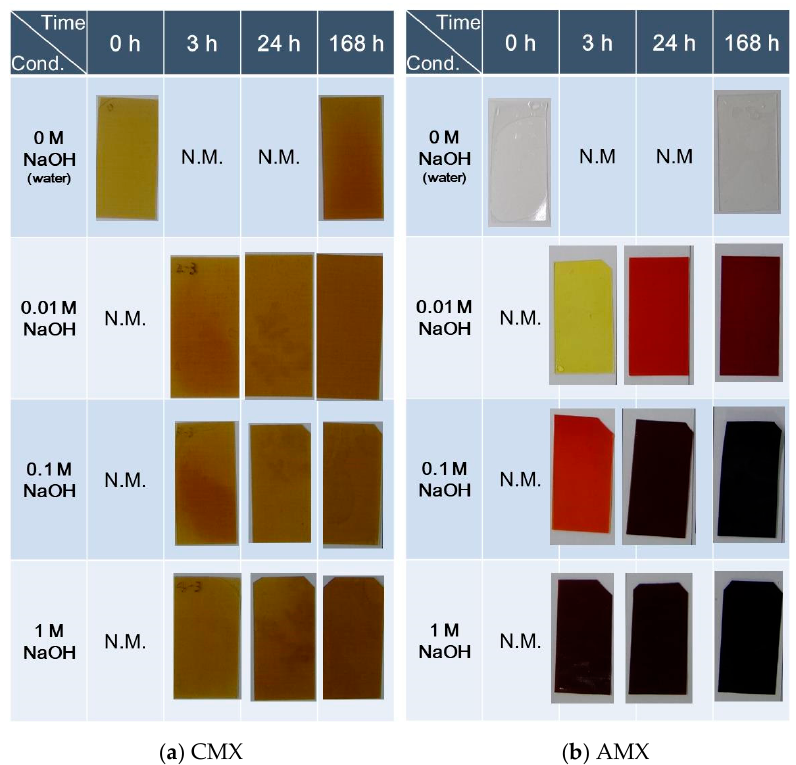
Figure 5. Color change of test pieces with respect to various NaOH concentrations and immersion time periods (40 °C); ( a ) CMX; ( b ) AMX (N.M - Not mentioned). The photos of AMX were cited from Reference [18] and rearranged.